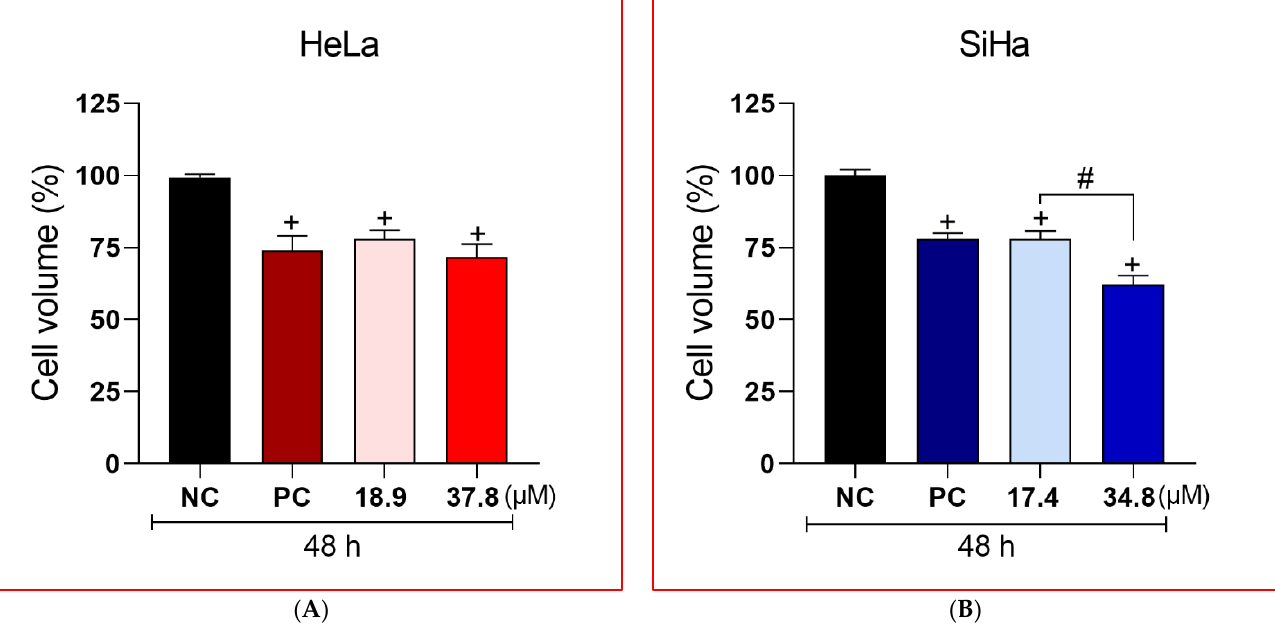
Figure 4. Effects of A3K2A3 on cervical cancer cell volume. Cells were treated with A3K2A3 (IC 50 or 2xIC 50 ) for 48 h. The PC was CPT (30 μM). Cell volume was analyzed by flow cytometry. Data represent the mean ± SD of three independent experiments that were performed in triplicate. ( A ) HeLa and ( B ) SiHa; + p < 0.05 compared to 48 h NC, # p < 0.05 significant difference between treatment concentrations (One-way ANOVA followed by post-Tukey test).